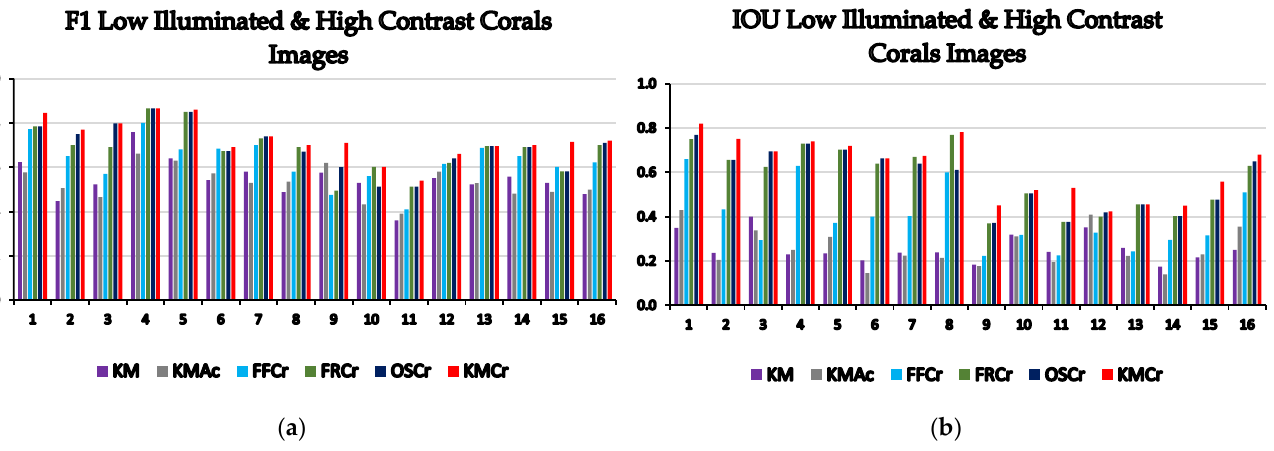
Figure 28. The results of evaluating the tested segmentation algorithms using low illuminated and high contrast seagrass images. Images (1 – 8) had two categories, and (8 – 16) had three categories: ( a ) F1-score; ( b ) IOU.